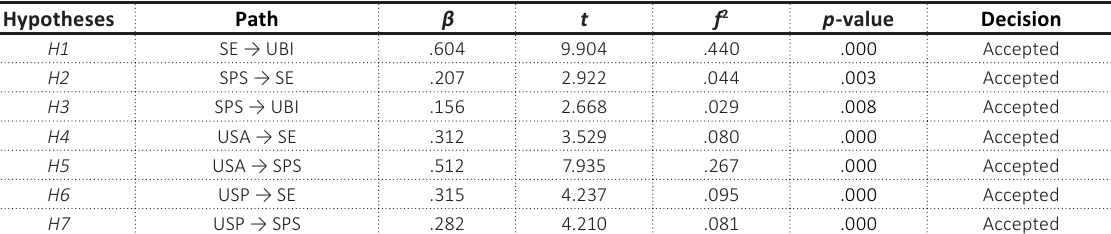
Table 4. Hypotheses testing